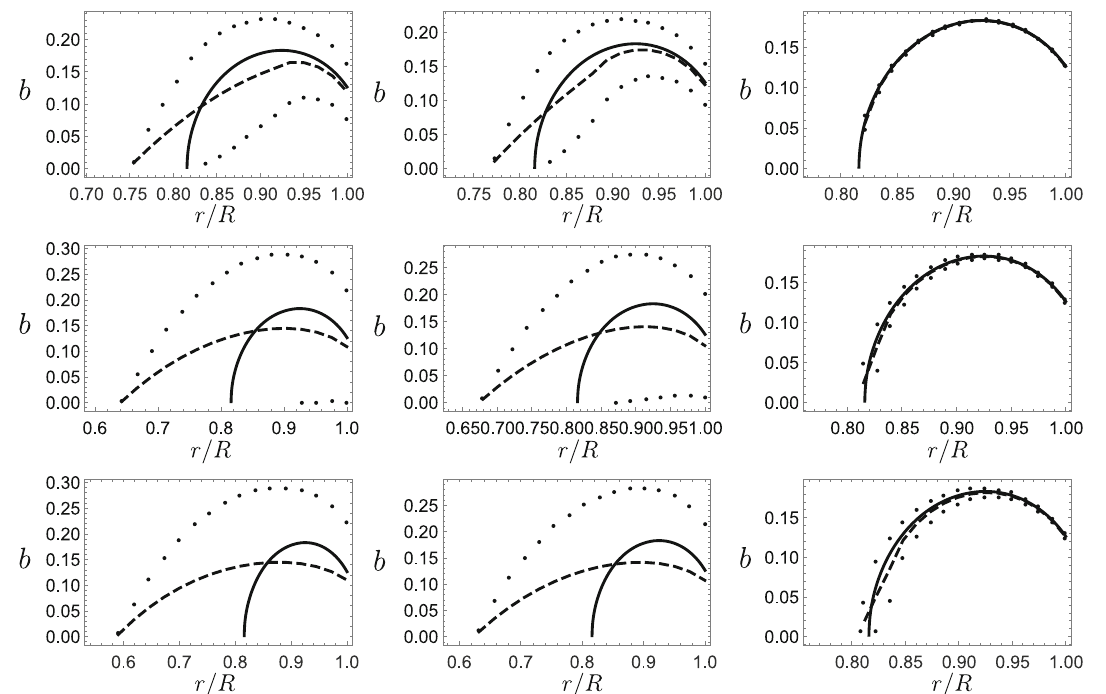
Fig. 15 The local trapping efficiency coefficient b for R / M = 2 . 8 is plotted for several values of j and θ . The solid line shows the local trap- ping for a non-rotating configuration and the dashed line shows local trapping for the rotating case. For the latter, the points above the dashed line are values for just counter-rotating directions of the null geodesics,